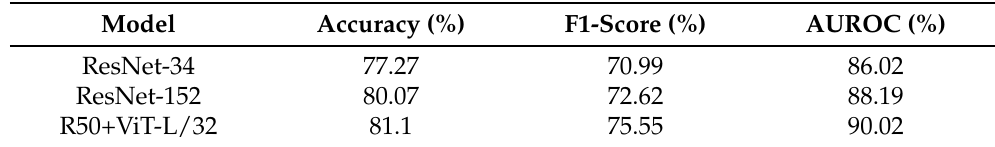
Table 3. Likelihood of the IAN Injury classification